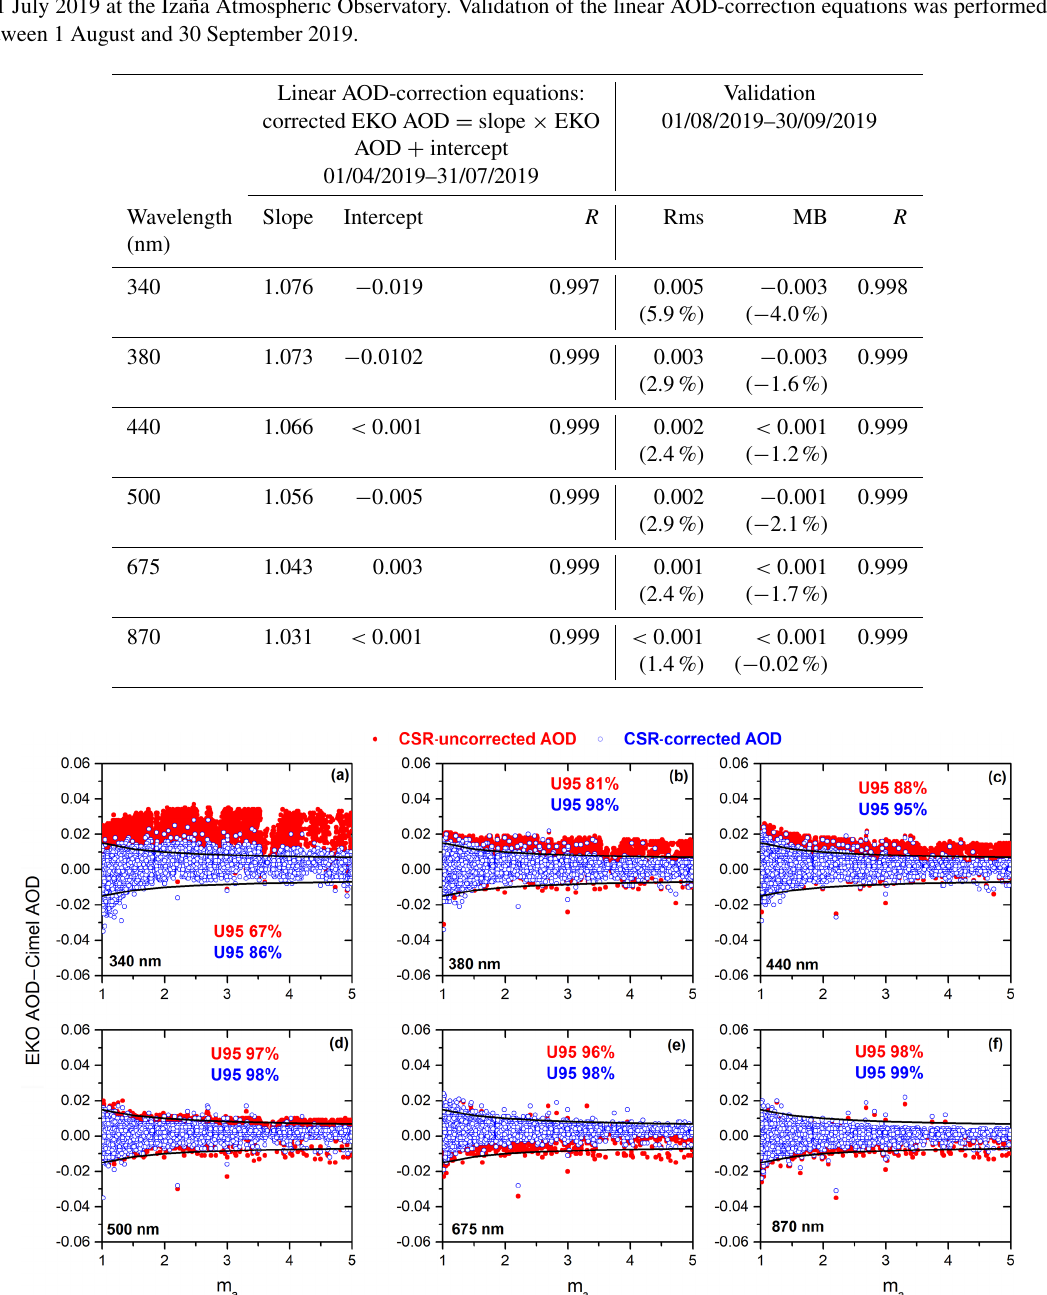
Table 5. Linear AOD-correction equations (slope and intercept) at 340, 380, 440, 500, 675, and 870nm obtained with data measured from